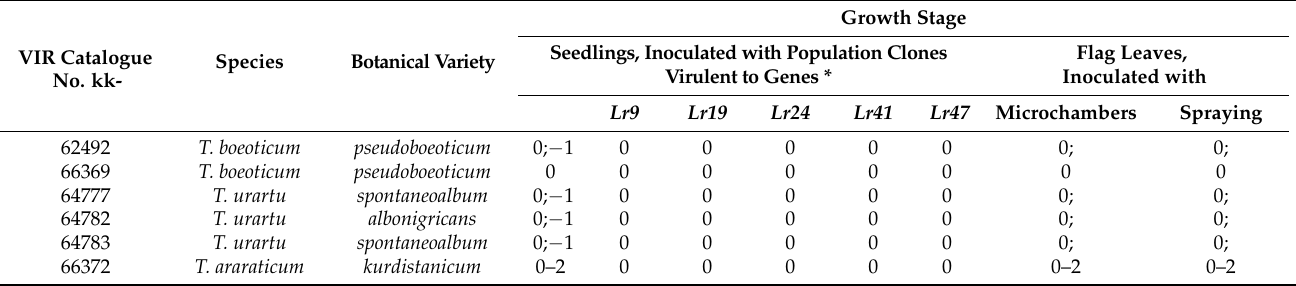
Table 3. Samples of wild wheat species from the VIR collection that are highly resistant to leaf rust.